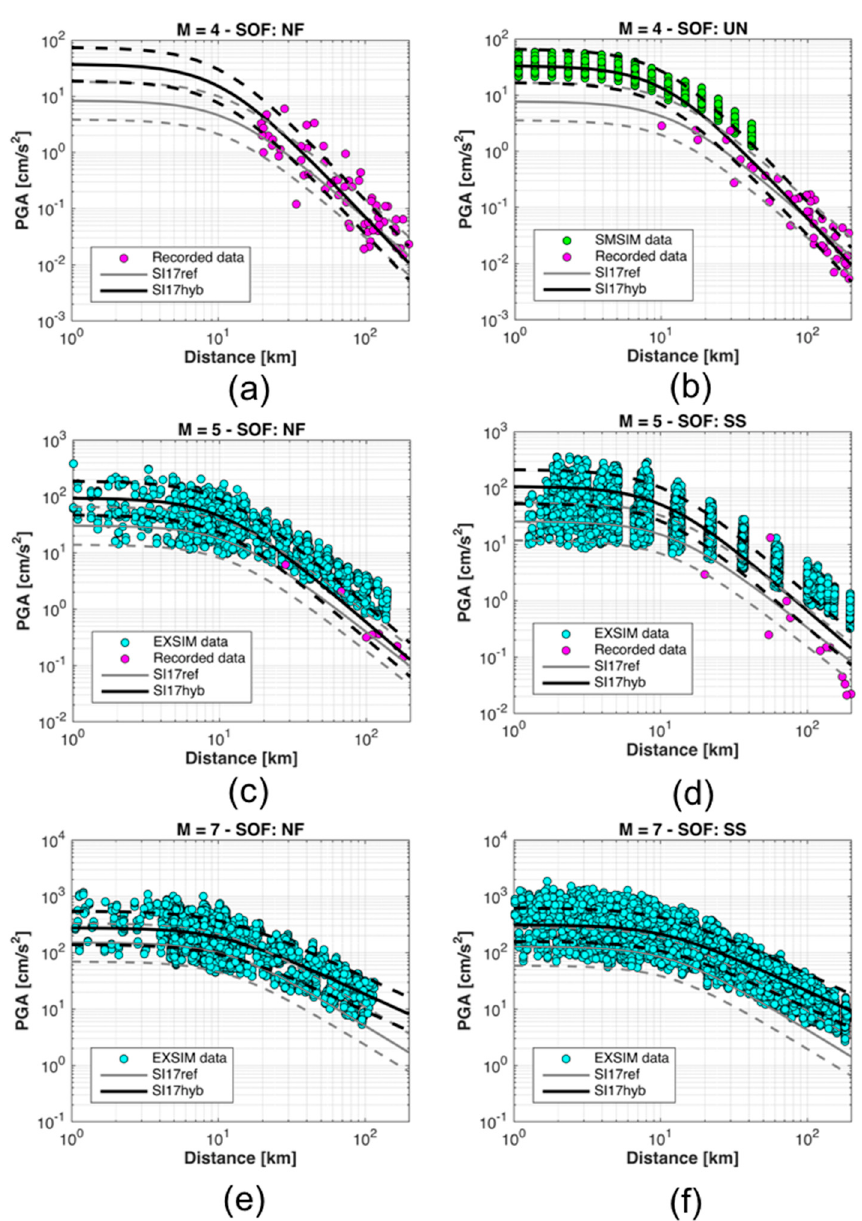
Figure 20. Peak ground acceleration (PGA) attenuation of hybrid (SI17hyb) and empirical (SI17ref) GMPEs with distance, for magnitude M = 4.0 with normal faulting (NF) ( a ); Magnitude M = 4.0 with undefined style of faulting (UN) ( b ); Magnitude M = 5.0 with normal faulting (NF) ( c ); Magnitude M = 5.0 with strike-slip (SS) ( d ); Magnitude M = 7.0 with normal faulting (NF) ( e ); and magnitude M = 7.0 with strike-slip (SS) ( f ). Magenta circles, empirical data points; green circles, SMSIM data points; cyan circles, EXSIM data points.